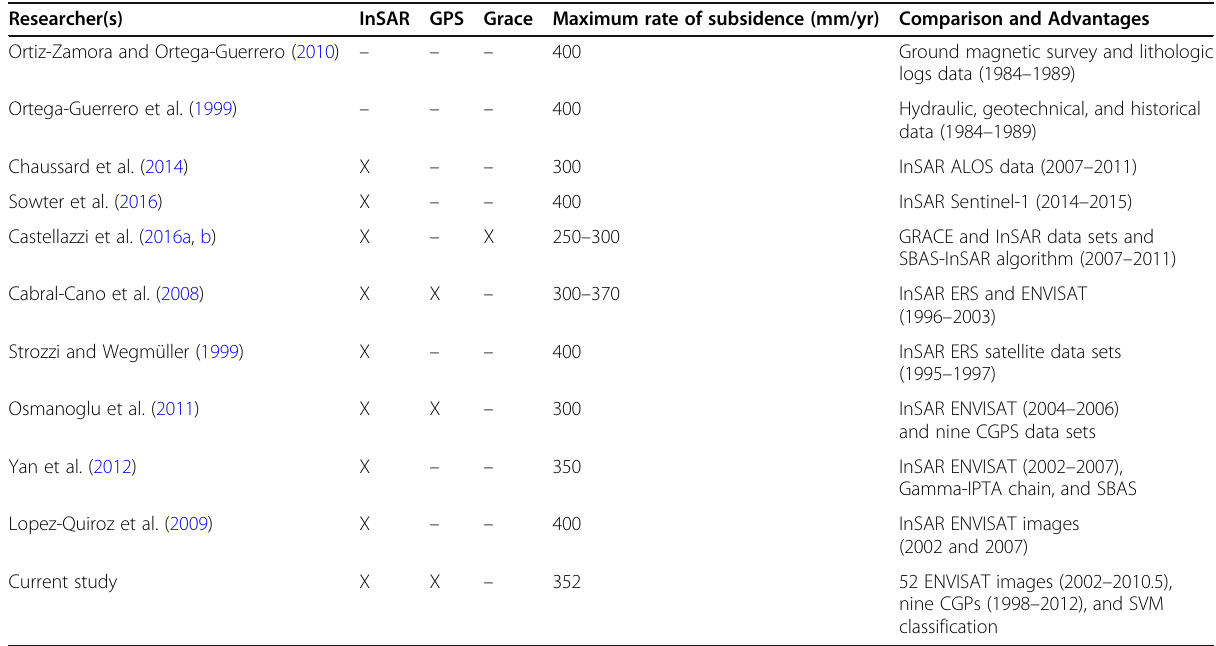
Table 5 Mexico City subsidence monitoring history